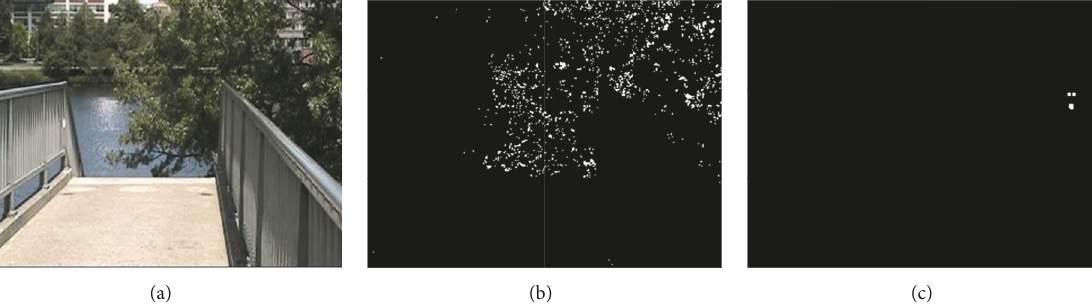
Figure5:Comparisonofthedynamicsituation.(a)Thethirteenthframeof“Overpass”video.(b)Thedetectionresultof[13].(c)Thedetection result of the proposed method.